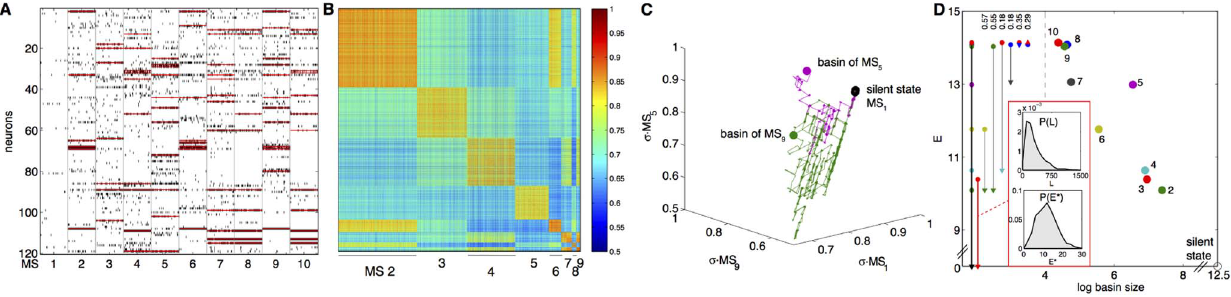
Figure 11. Energy landscape in a N =120 neuron K-pairwise model. ( A ) The 10 most frequently occurring metastable (MS) states (active neurons for each in red), and 50 randomly chosen activity patterns for each MS state (black dots represent spikes). MS 1 is the all-silent basin. ( B ) The overlaps, C mn , between all pairs of identified patterns belonging to basins 2,...,10 (MS 1 left out due to its large size). Patterns within the same basin are much more similar between themselves than to patterns belonging to other basins. ( C ) The structure of the energy landscape explored with Monte Carlo. Starting in the all-silent state, single spin-flip steps are taken until the configuration crosses the energy barrier into another basin. Here, two such paths are depicted (green, ultimately landing in the basin of MS 9; purple, landing in basin of MS 5) as projections into 3D space of scalar products (overlaps) with the MS 1, 5, and 9. ( D ) The detailed structure of the energy landscape. 10 MS patterns from (A) are shown in the energy (y- axis) vs log basin size (x-axis) diagram (silent state at lower right corner). At left, transitions frequently observed in MC simulations starting in each of the 10 MS states, as in (C). The most frequent transitions are decays to the silent state. Other frequent transitions (and their probabilities) shown using vertical arrows between respective states. Typical transition statistics (for MS 3 decaying into the silent state) shown in the inset: the distribution of spin-flip attempts needed, P ( L ), and the distribution of energy barriers, P ( E (cid:4) ) , over 1000 observed transitions.